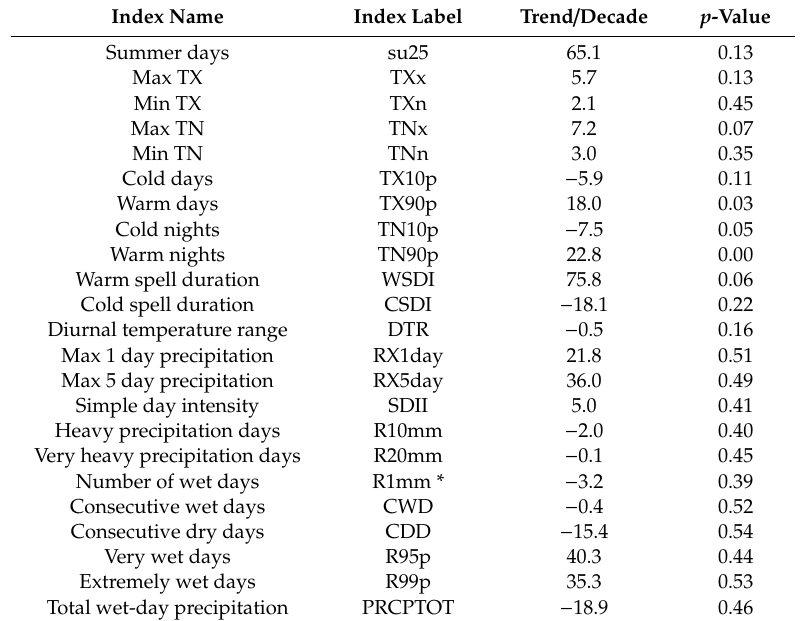
Table 1. Observation based ETCCDI defined 27 climate extremes trends for the period